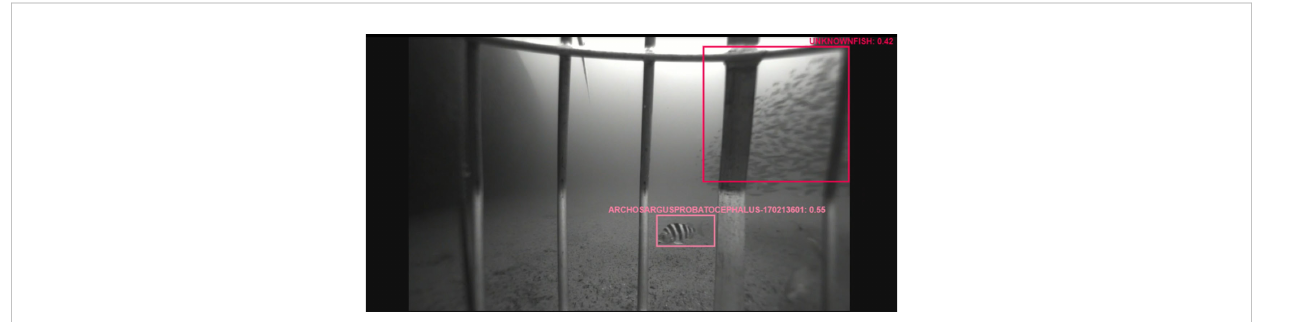
FIGURE 10 Example of a successful detection of a Sheepshead ( Archosargus probatocephalus ) with juxtaposition to the breakdown of performance with large schools of small, less distinguishable fi sh